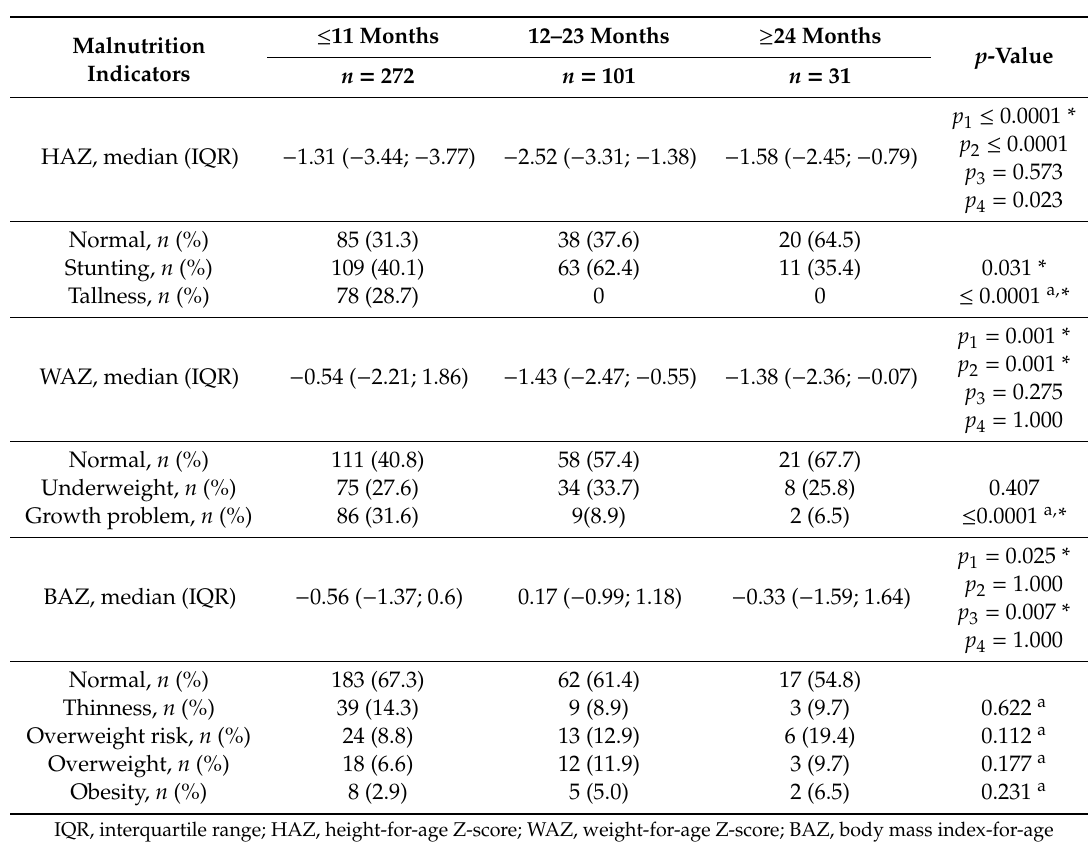
Table 4. Comparison of medians and prevalence of malnutrition indices among children by